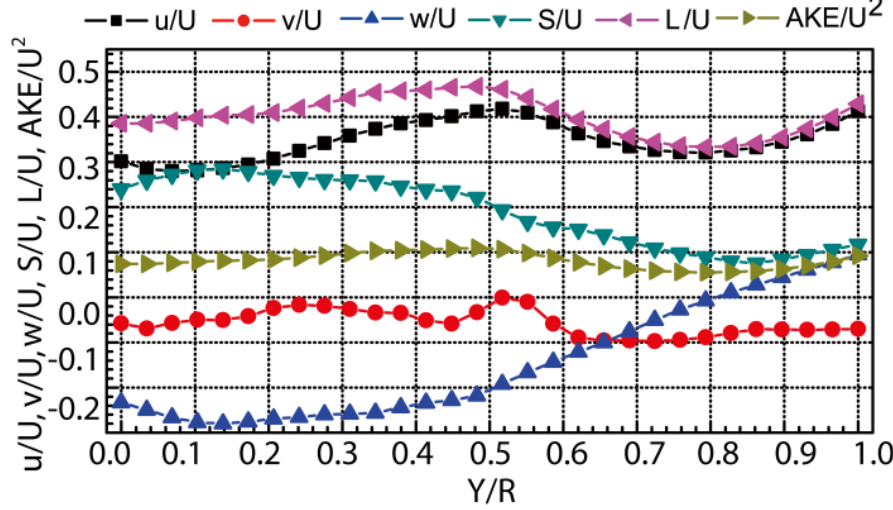
/ U 2 profiles at Z / R = 0.00 under the ballast